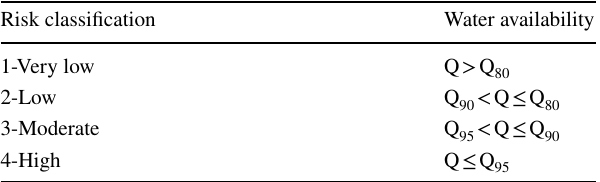
Table 2 Classes of the risk severity according to the water availability Risk classification